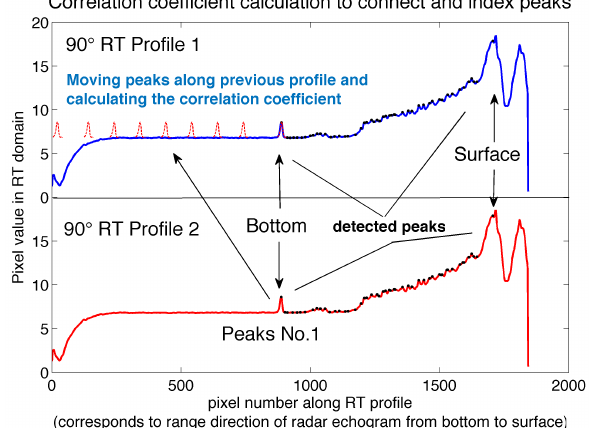
Figure 8. The calculation of the correlation coefficient to connect and index peaks, which correspond to the segmented lines (The black dots on the line are detected peaks).